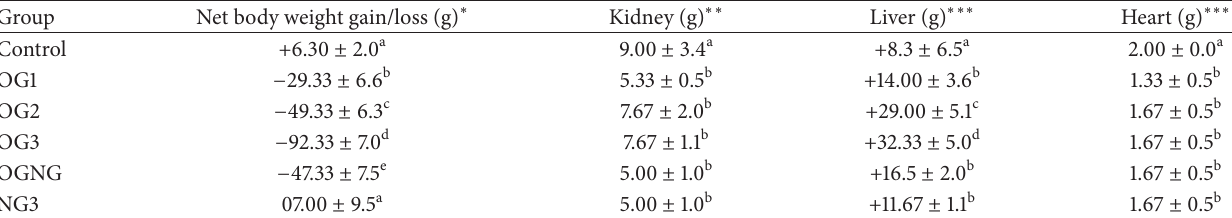
Values are expressed as mean ± SD of 𝑛 = 3 . Mean with different superscript letters (a–e) in the column differs significantly at ∗ ( 𝑝 < 0.01 ), ∗∗ ( 𝑝 < 0.05 ), and ∗∗∗ ( 𝑝 < 0.001